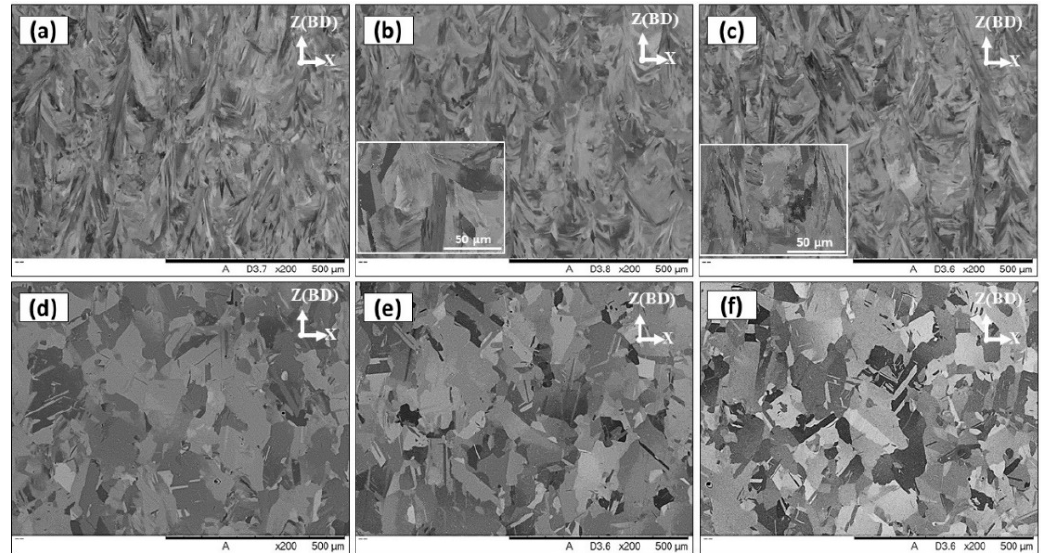
Figure 9. SEM micrograph of non-etched laser powder bed fused IN718 in conditions: ( a ) as-printed; ( b ) HS1; ( c ) HS2; ( d ) HS3; ( e ) HS4; ( f ) HS5.